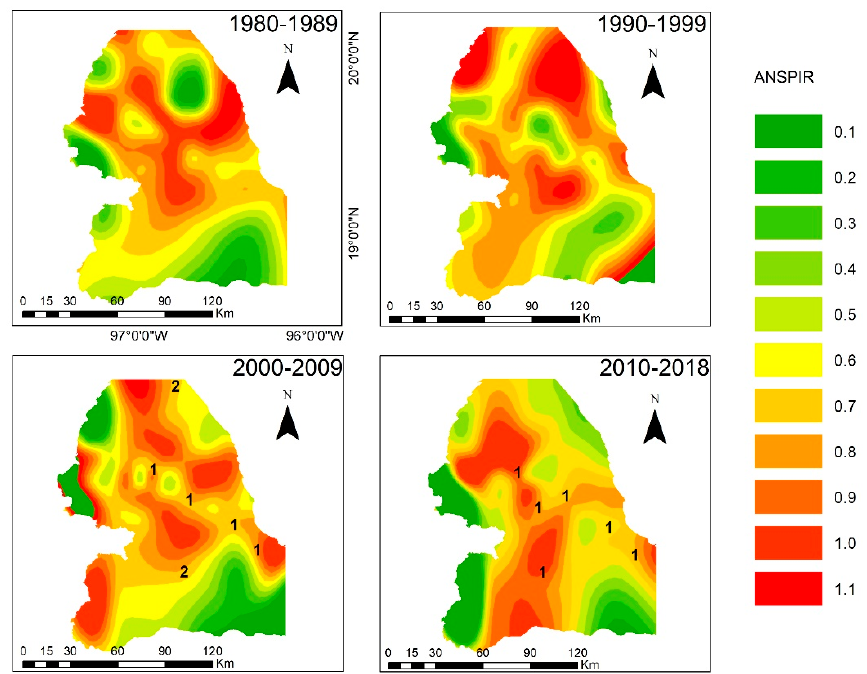
Figure 2. Behavior of ANSPIR per decade in the study area (the 1980s, 1990s, 2000s, and 2010–2018 periods). The numbers over the territory indicate the total drought declarations per municipality (EDND) in the Veracruz state.